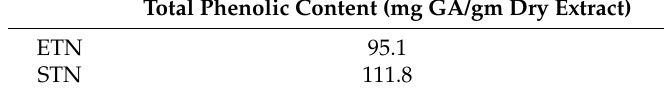
Table 3. Total phenolic content of ETN and STN.